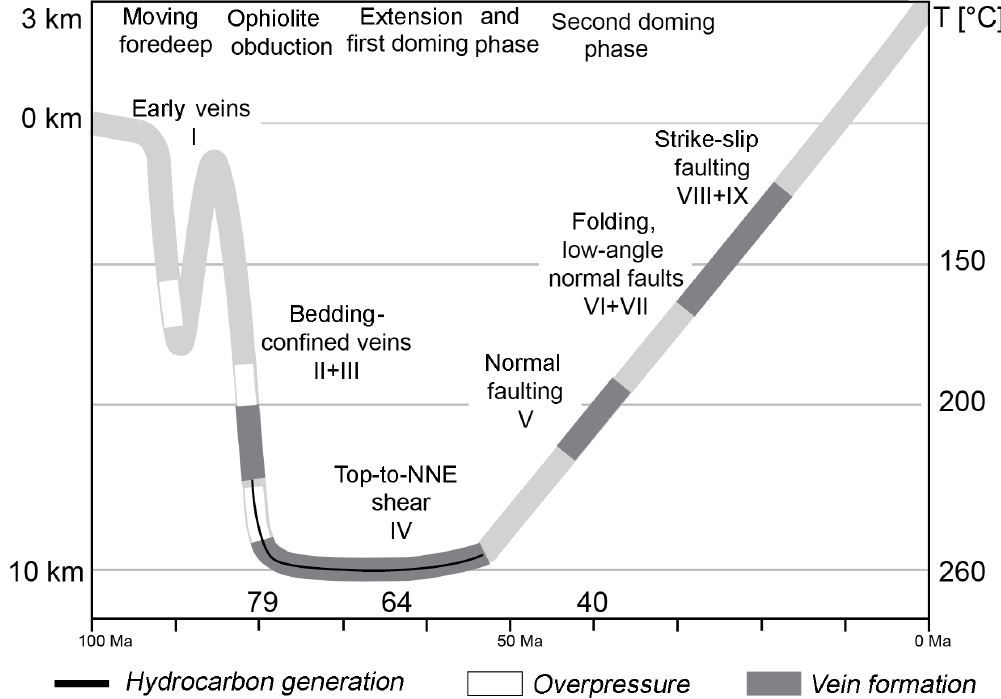
Figure 12. Summary sketch of burial and exhumation for the top of the carbonate platform (Natih Fm.) integrating all presented datasets. Headings refer to the tectonic phases and captions to the structural generations I-IX (Grobe et al., 2018); enlarged ages reflect deepest burial reached at ca. 79Ma, the onset of initial dome formation at 64Ma (top-to-NNE shearing), and rapid exhumation active at 40Ma. Tempera- tures on the right are based on RSCM and FI thermometry. Pressure at peak burial is calculated from FI measurements and independently determined temperature data to p p = 254 ± 30MPa and p L = 340MPa. The exhumation history is reconstructed from ZHe